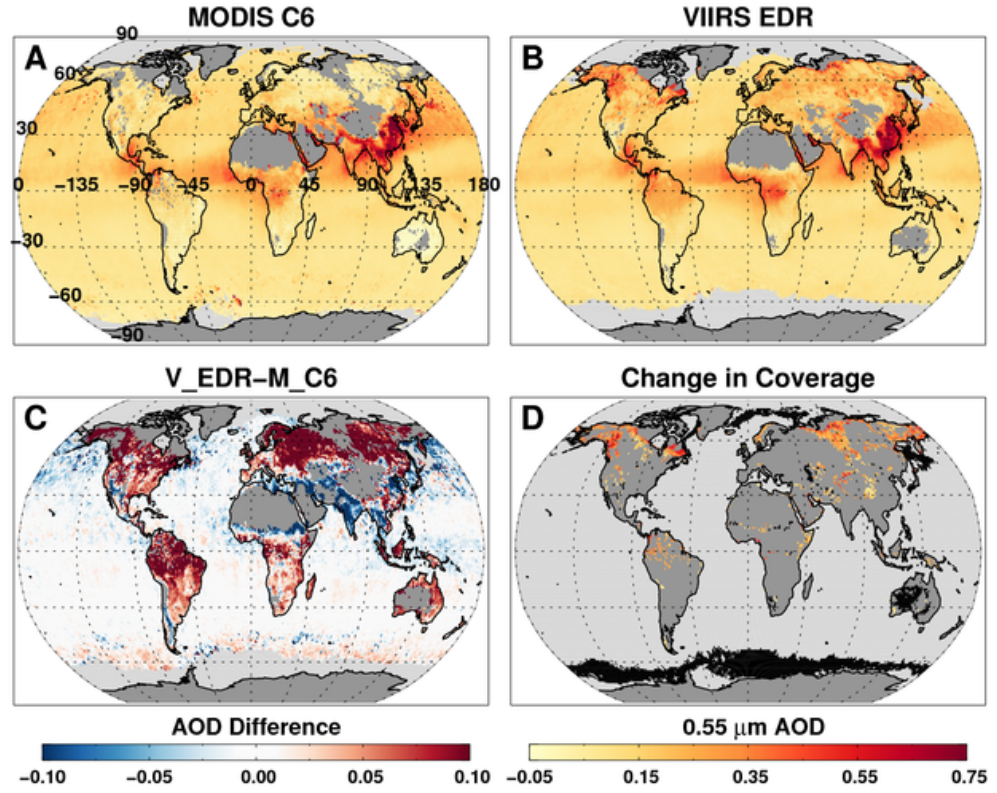
Figure 3. Spring (March–April–May) 2013 maps (1 ◦ × 1 ◦ ) of QA-filtered mean AOD at 0.55µm, derived from the MODIS C6 (a) and VIIRS EDR (b) products. (c) plots the difference between (b) and (a) . (d) represents the “increased” coverage of VIIRS-EDR using AOD units, with reduced coverage plotted as black. Note that the seasonal AOD in a gridbox is the average of three monthly AODs, which in turn are derived as the average of daily AOD within each month. Published QA-filtering for each product is followed.